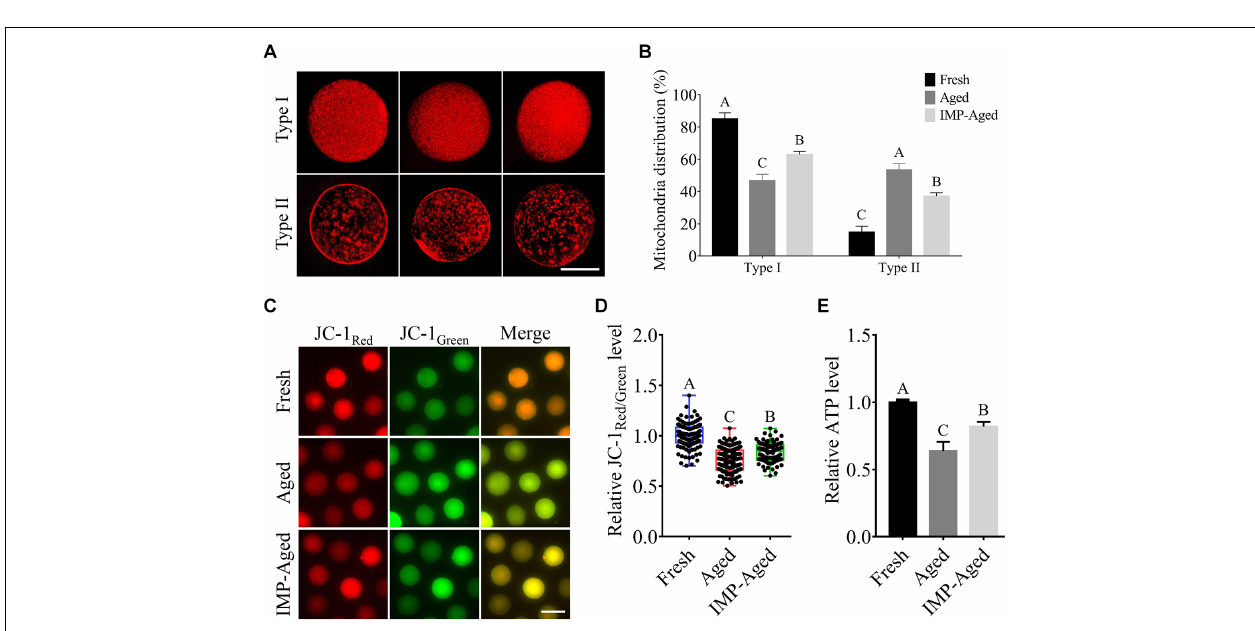
FIGURE 5 | Effects of IMP on mitochondrial distribution, (cid:49)(cid:57) m, and ATP levels in aged oocytes. (A) Representative images of Type I/II (three each) mitochondrial distribution in oocytes with MitoTracker staining. Scale bar = 50 µ m. (B) The proportion of Type I/II oocytes in fresh ( N = 119), aged ( N = 76), and IMP-treated aged ( N = 99) groups. Significant differences are represented by different capital letters ( P < 0.01). R = 3. (C) Representative images of JC-1 Red / Green staining in fresh, aged, and IMP-treated aged oocytes. Scale bar = 100 µ m. (D) Relative fluorescence intensity of JC-1 Red / Green in fresh ( N = 128), aged ( N = 122), and IMP-treated aged ( N = 120) oocytes. Significant differences are represented by different capital letters ( P < 0.01). R = 3. (E) Relative ATP levels in fresh, aged, and IMP-treated aged oocytes. R = 3. Significant differences are represented by different capital letters ( P <